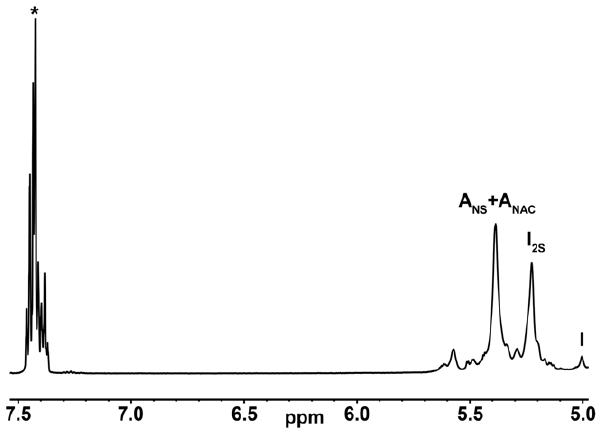
Figure 6. Selected 1 H NMR region showing the benzyl alcohol signals found on the contaminated heparin samples spectra. Signals due to benzyl alcohol are highlighted by asterisks. A NAC , 2- deoxy-2-acetylamino-D-glucopyranose; A NS , 2-deoxy-2-sulfoamino-D- glucopyranose; I 2S , 2-O-sulfo-iduronic acid; I, iduronic acid.